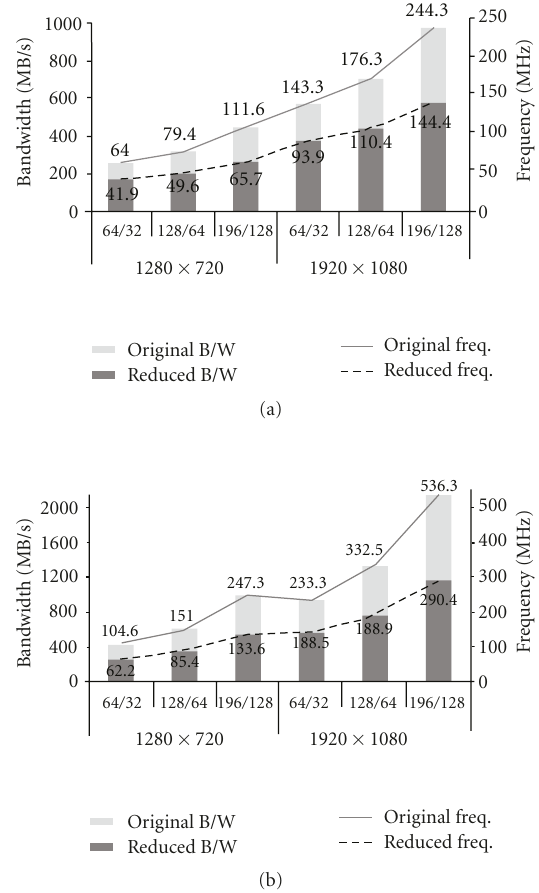
Figure 17: Reduction of the bandwidth requirement by the proposed FMC. (a) 1 reference frame. (b) 3 reference frames.